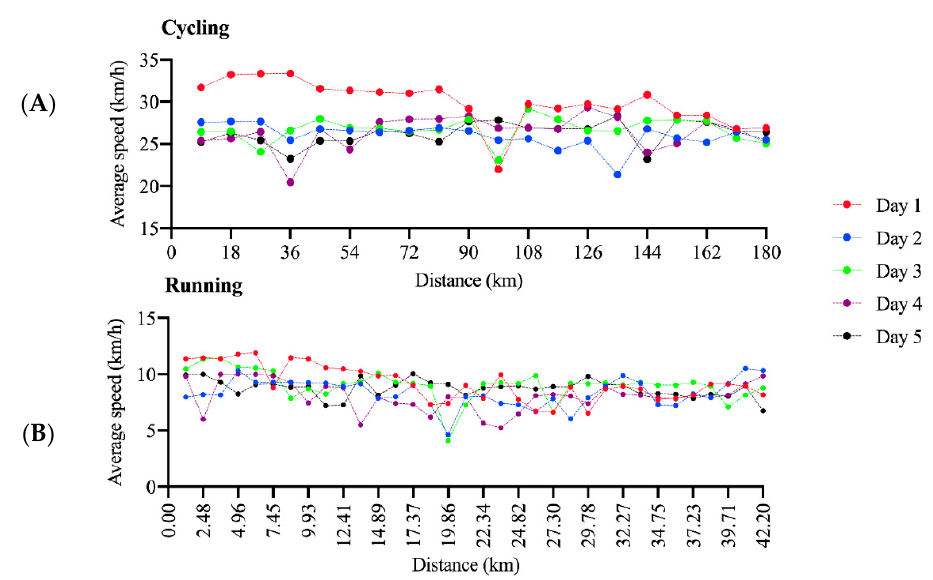
Figure 1. Pacing in each of the five days in a Quintuple Iron ultra-triathlon in the cycling ( A ) and cycling and 42.195 km of running.